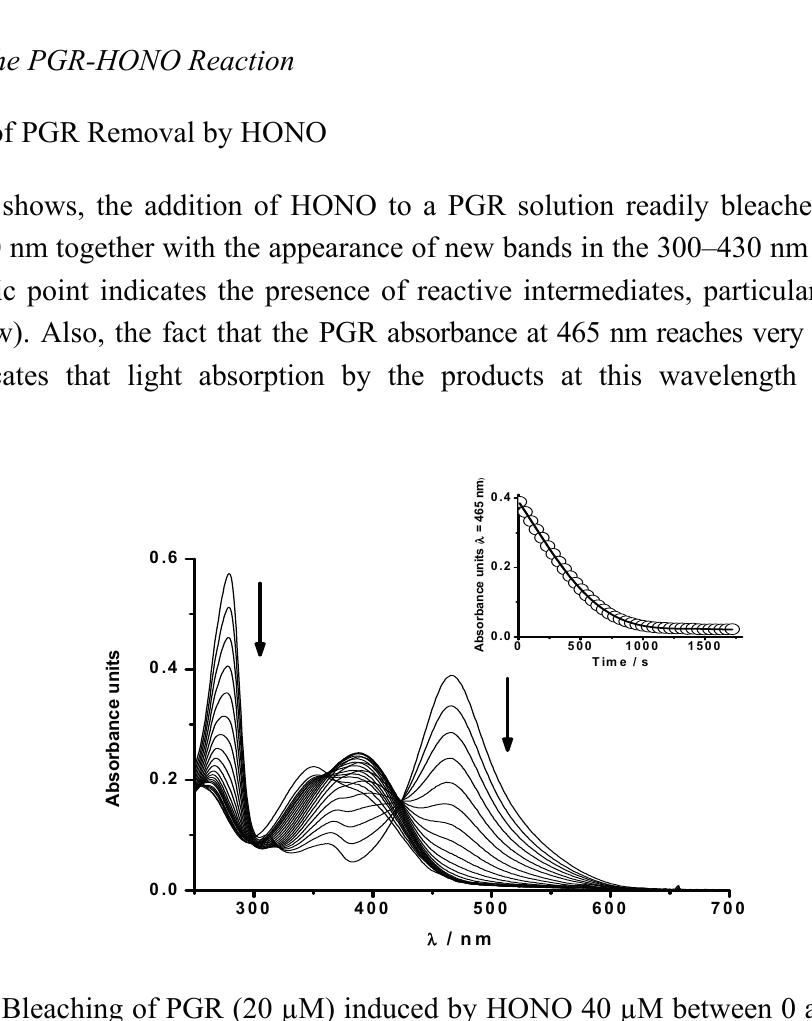
Figure 1. Bleaching of PGR (20 µM) induced by HONO 40 µM between 0 and 50 min